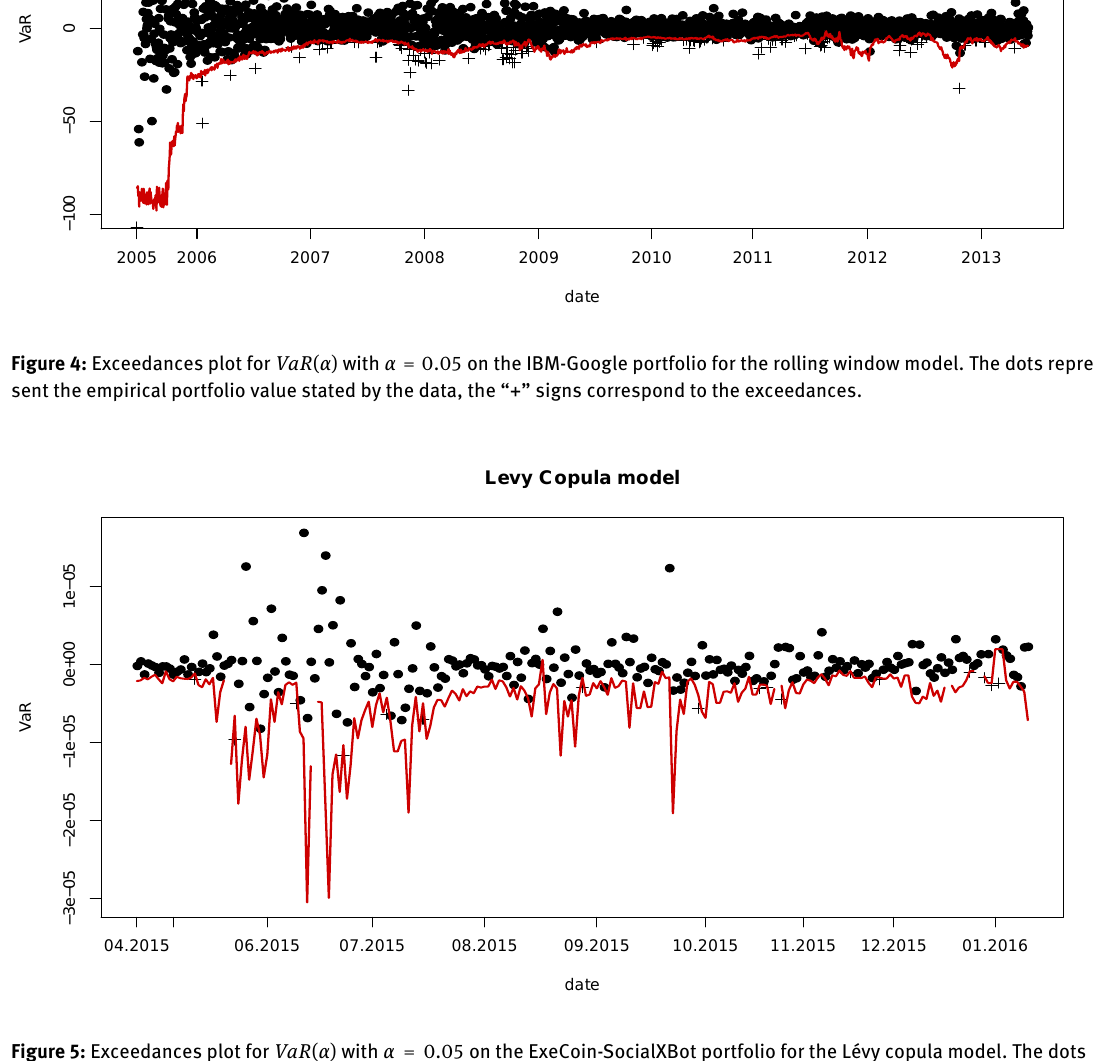
Figure 5: Exceedances plot for VaR ( α ) with α = 0.05 on the ExeCoin-SocialXBot portfolio for the Lévy copula model. The dots represent the empirical portfolio value stated by the data, the “+” signs correspond to the